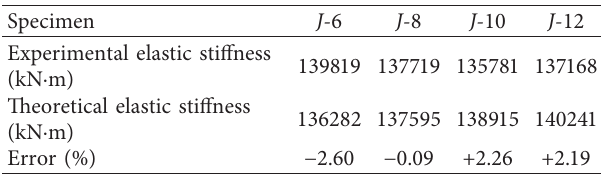
Table 5: Comparison of the experimental and the theoretical elastic stiffness.